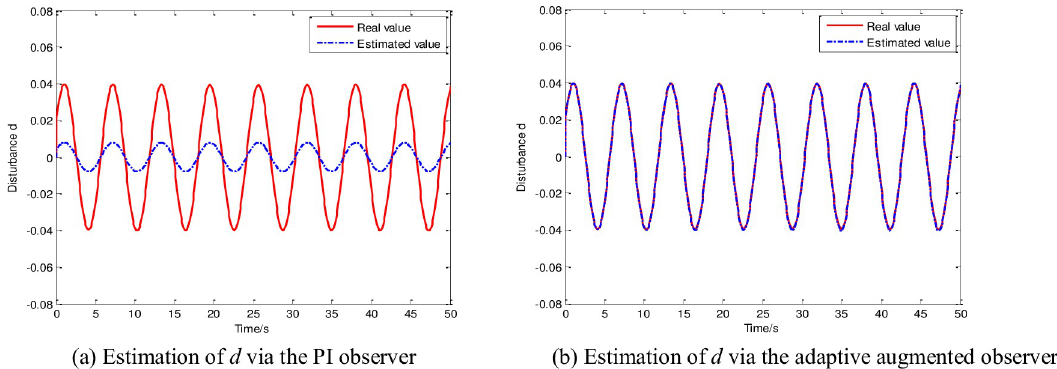
Fig 6. Disturbance estimation results via different observers. (a) Estimation of d via the PI observer, (b) Estimation of d via the adaptive augmented observer.